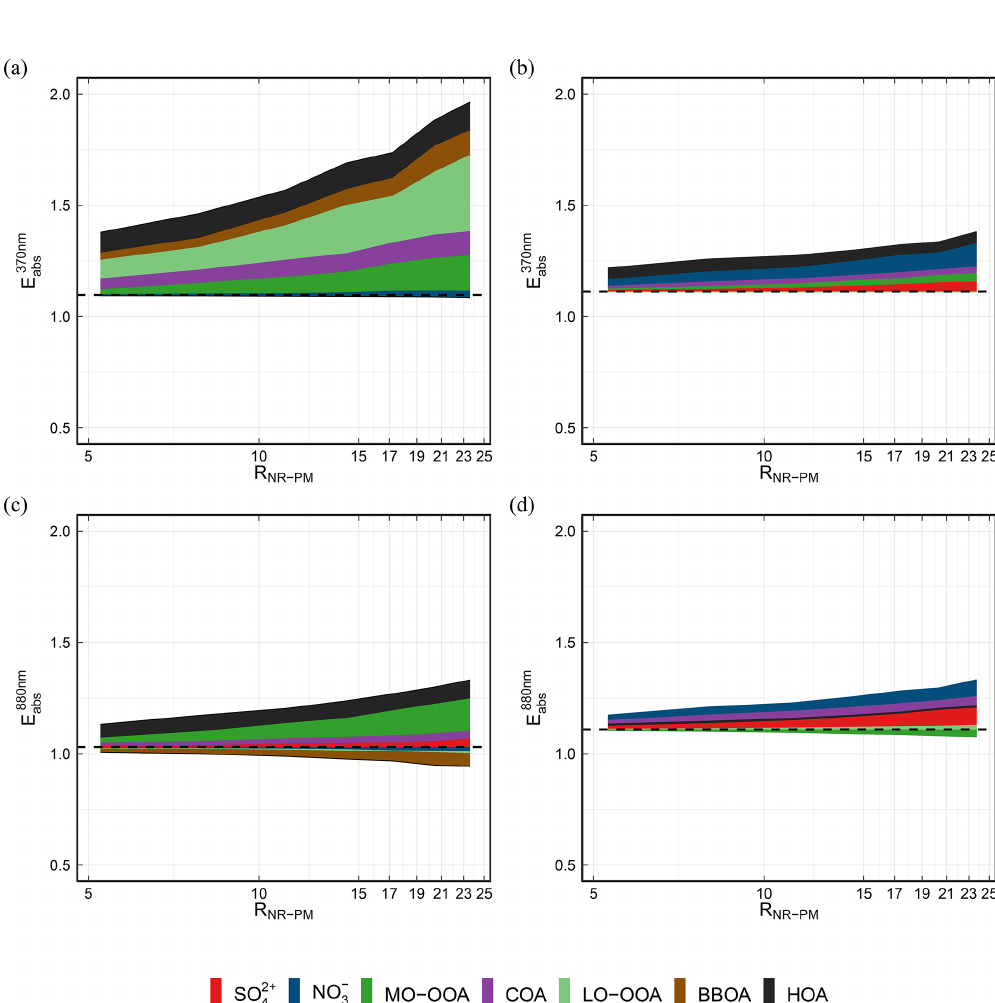
Figure 4. Contribution to the absorption enhancement, E abs , as a function of the amount of coating material R NR-PM for the different organic and inorganic sources found in BCN during the cold season (a, c) and warm season (b, d) for 370 (a, b) and 880nm (c, d) . The contribution for each source was computed by applying the coefficient obtained with the mlr analysis (see Table 3) to the ratio that compound-to-EC had as R NR-PM increased. It should be noted that for each season and wavelength, we have set the corresponding intercept of the mlr analysis as reference value above/below in which each compound presented a positive/negative influence on E abs